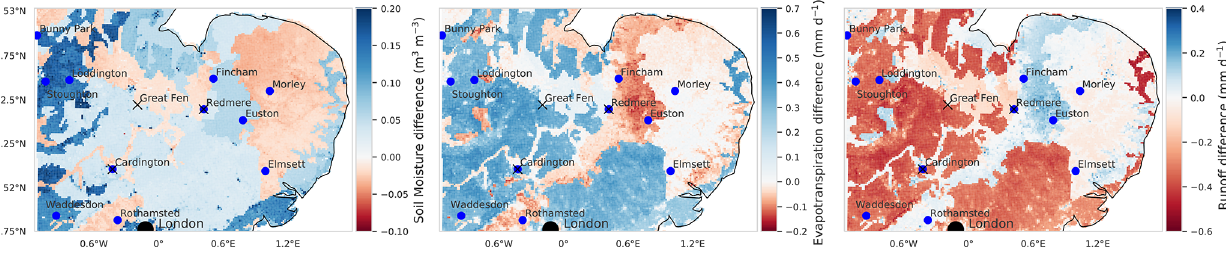
Figure 6. Map showing the difference between yearly mean soil moisture for the prior and posterior ensemble of JULES model runs in 2016. Blue corresponds to the posterior ensemble estimate being wetter, and red corresponds to the posterior being drier.